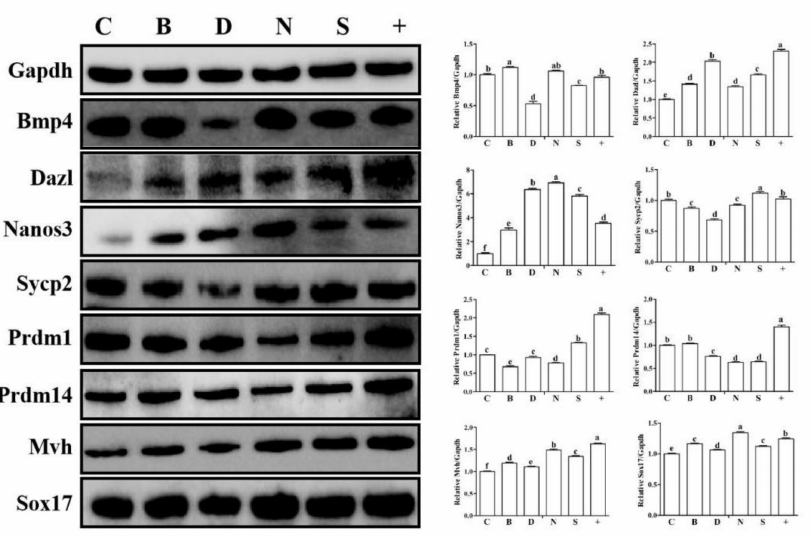
Figure 6. Germ cell related gene expression changes after the overexpression of bmp4 , dazl , nanos3 and sycp2 in sheep Leydig cells. Western blot analysis was performed to determine the overexpression efficiency of CRISPR/dcas9 system in vitro. C, B, D, N, S, and + represent the control, bmp4 , dazl , nanos3 , sycp2 and mix of four gene groups, respectively. The results were expressed relative to the control group C as mean values ± the SEM. Different letters mean significant differences between groups ( p <